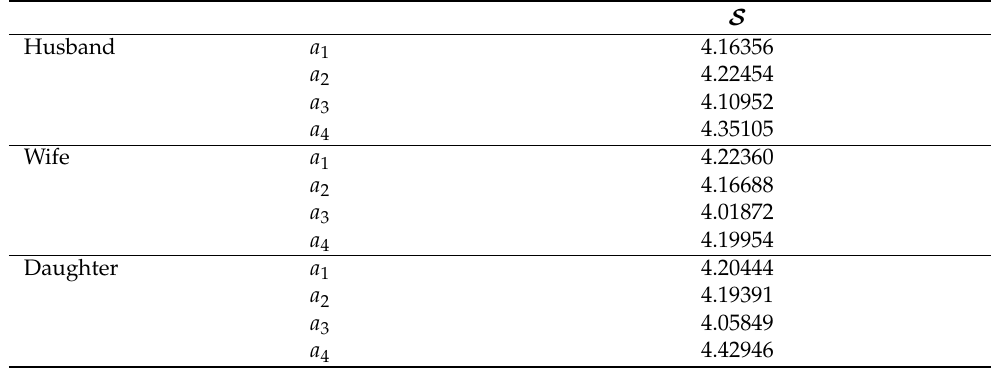
Table 7. Information of the score vector S